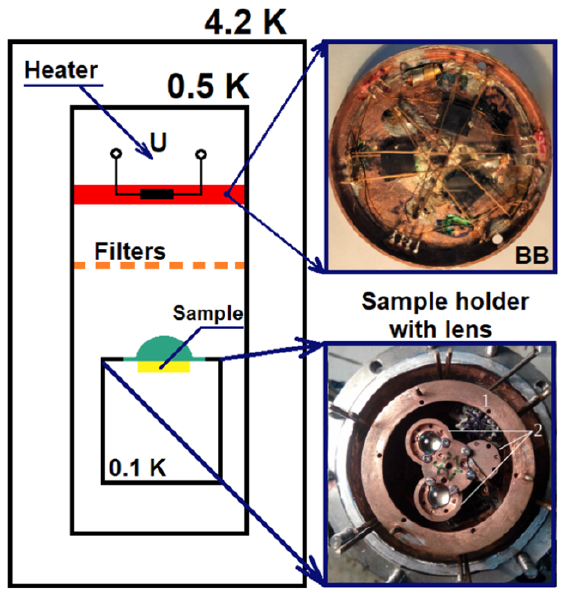
Figure 12. Schematic view of experimental setup ( left ). Photos from [43], top —He3 radiation shield with blackbody source; bottom —sample holders with sapphire lenses.